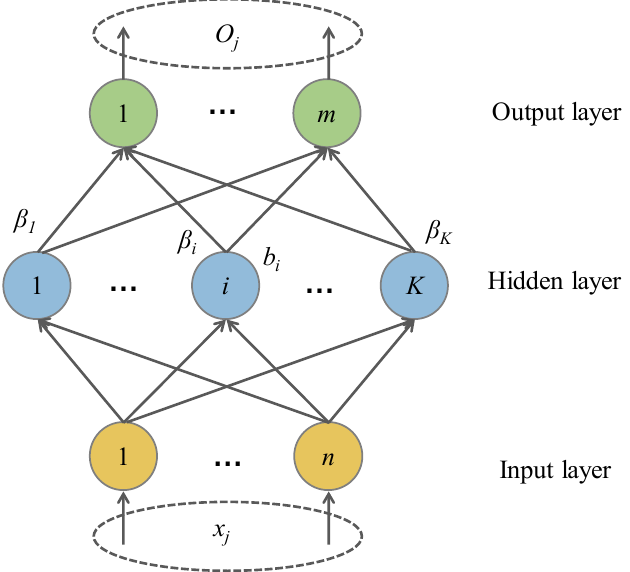
Figure 1. Extreme Learning Machine Network Structure.